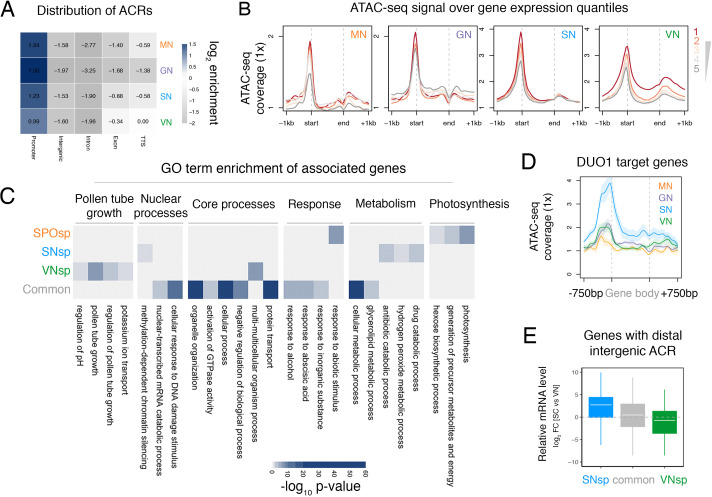
ATAC-seq profiling across Arabidopsis pollen development.(A) Distribution of genomic features associated with ATAC-seq peaks recovered from nuclei of microspores (MN), germ cells (GN), sperm (SN), and vegetative cells (VN). (B) Distribution of ATAC-seq signal over genes sorted by expression level in each respective cell type. ATAC-seq signal for GN is plotted over quintiles of gene expression in sperm. (C) Heatmap summarising the gene ontology (GO) terms enriched within the different groups of accessible chromatin regions (ACRs) defined in Figure 1E. Significant enrichment was assessed using g:Profiler and controlled for the multiple testing problem using the in-built g:SCS (sets counts and sizes) correction. (D) Averaged ATAC-seq enrichment over direct DUO1 target genes (Borg et al., 2011). Plotted is the ATAC-seq signal normalised to 1× Arabidopsis genome coverage. Shading represents the standard error. (E) Boxplot summarising the relative expression level of genes closest to different groups of distal intergenic ACRs. Plotted is the relative expression level between sperm and the VN. Each boxplot indicates minimum and maximum values as well as 25th, 50th, and 75th quartiles.